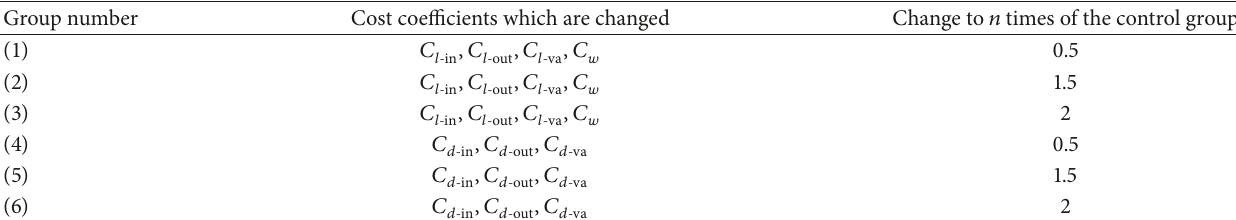
Figure 7: Testing result of serving time at the FL. Table 4: Selection of the cost